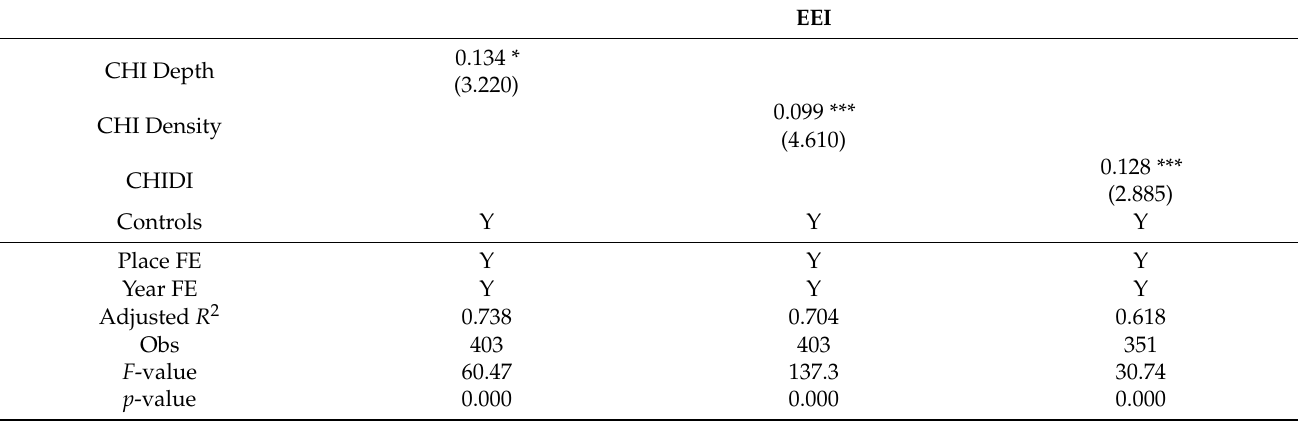
Table 4. Robustness Tests.